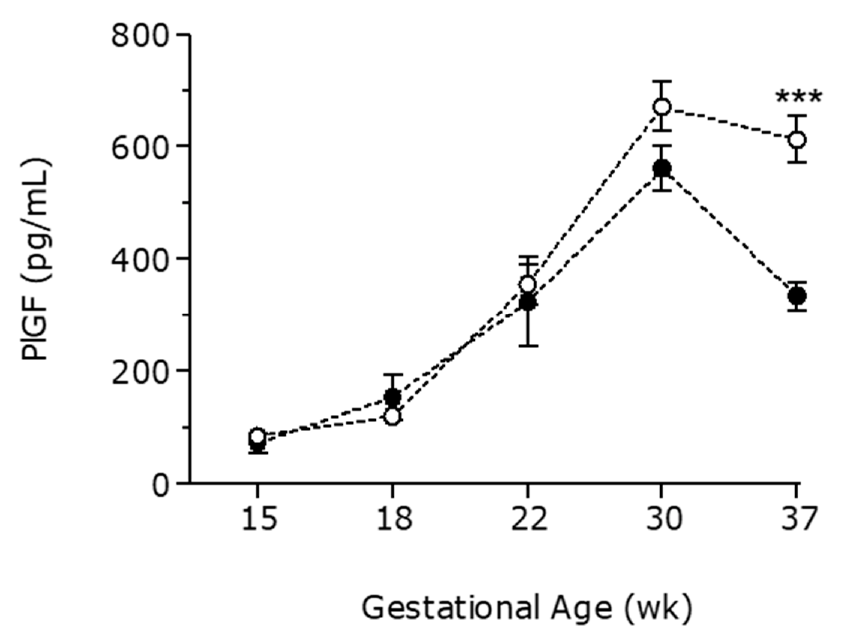
Figure 2. Maternal plasma concentrations of placental growth factor (PlGF) in the control group (white points) and pregnant women affected by breast cancer (black points). Differences were analyzed by two-way analysis of variance. Data are presented as mean with SEM. ***, p < 0.001.